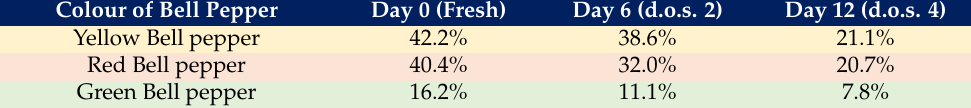
Figure 6. Second Freshness index for Bell pepper fruit classified by fruit colour, yellow (top-left), red (middle, right) and green (bottom), stored over 14 days ( ± SD)-scale varies. Table 4. Freshness index based on the difference between light reflection at 630 nm and 500